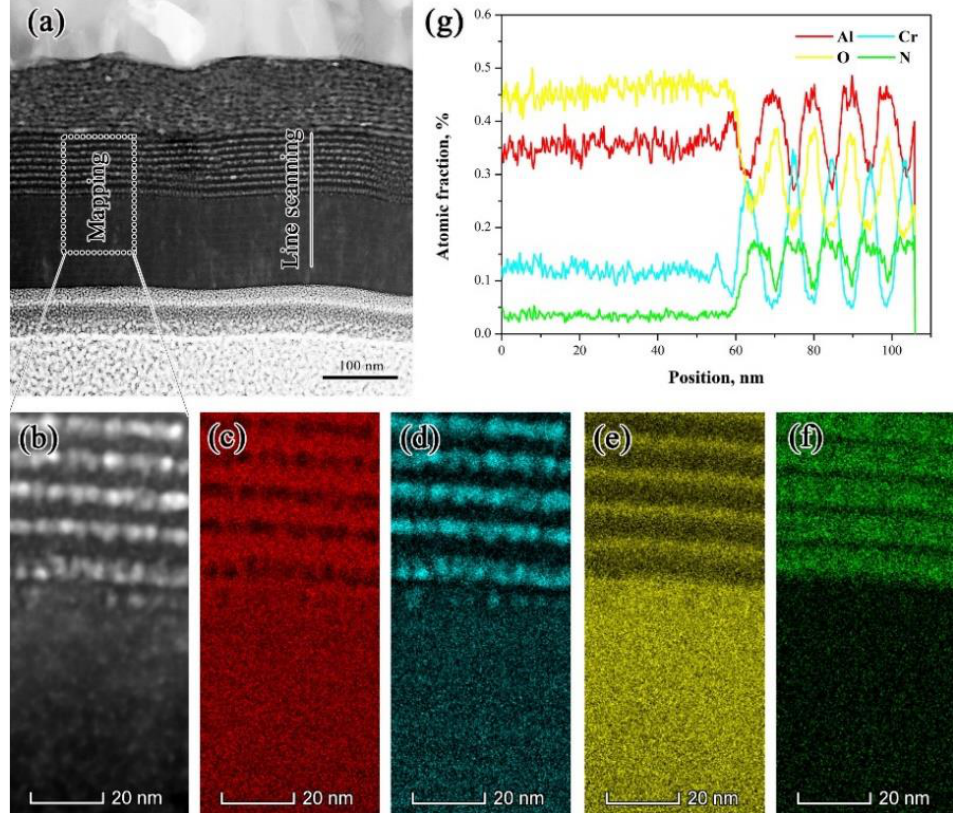
Figure 3. ( a ) Cross-sectional bright field TEM image of the sample annealed at 500 °C for 1000 h in ambient air. The rectangular box denotes the location of the chemical component mapping ( b – f ), and the EDS line scan data are shown in panel ( g ).